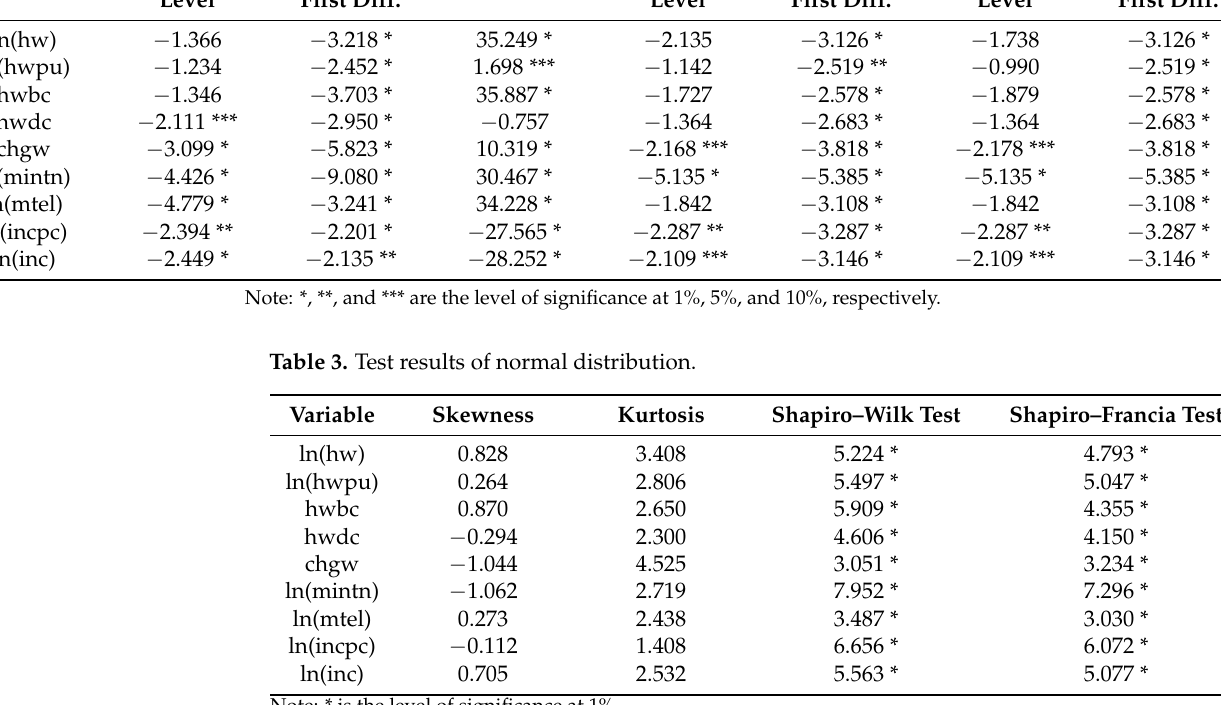
Table 2. Results of the cross-section dependence test and the first- and second-generation panel unit root tests. Testing